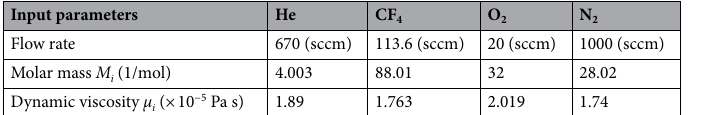
Table 1. Input parameters in the simulation.